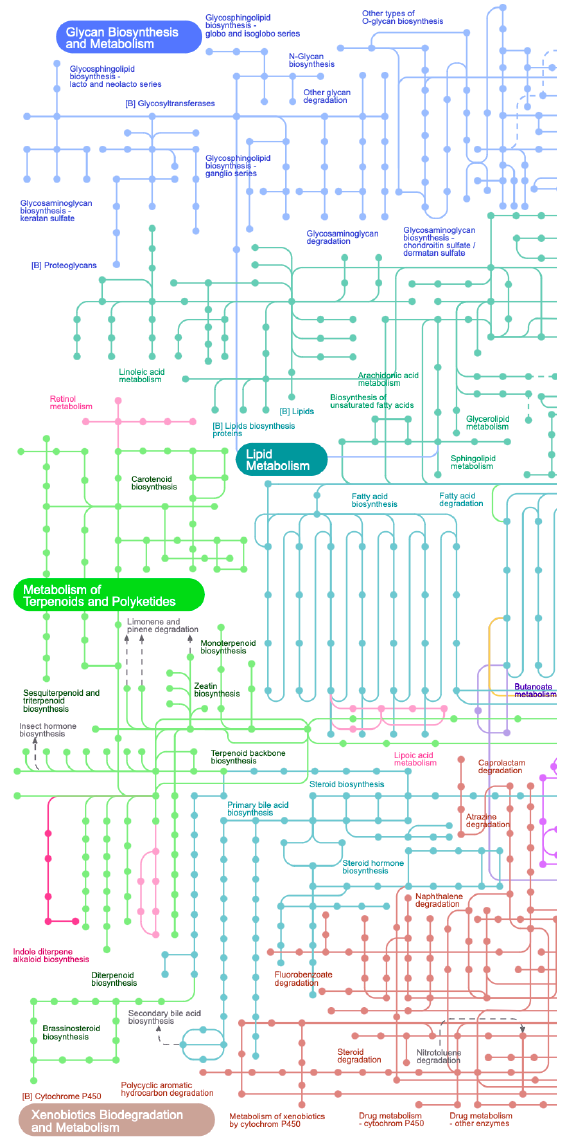
Figure 3. Visualization of metabolic pathways and profile data [28] made with iPath [29].